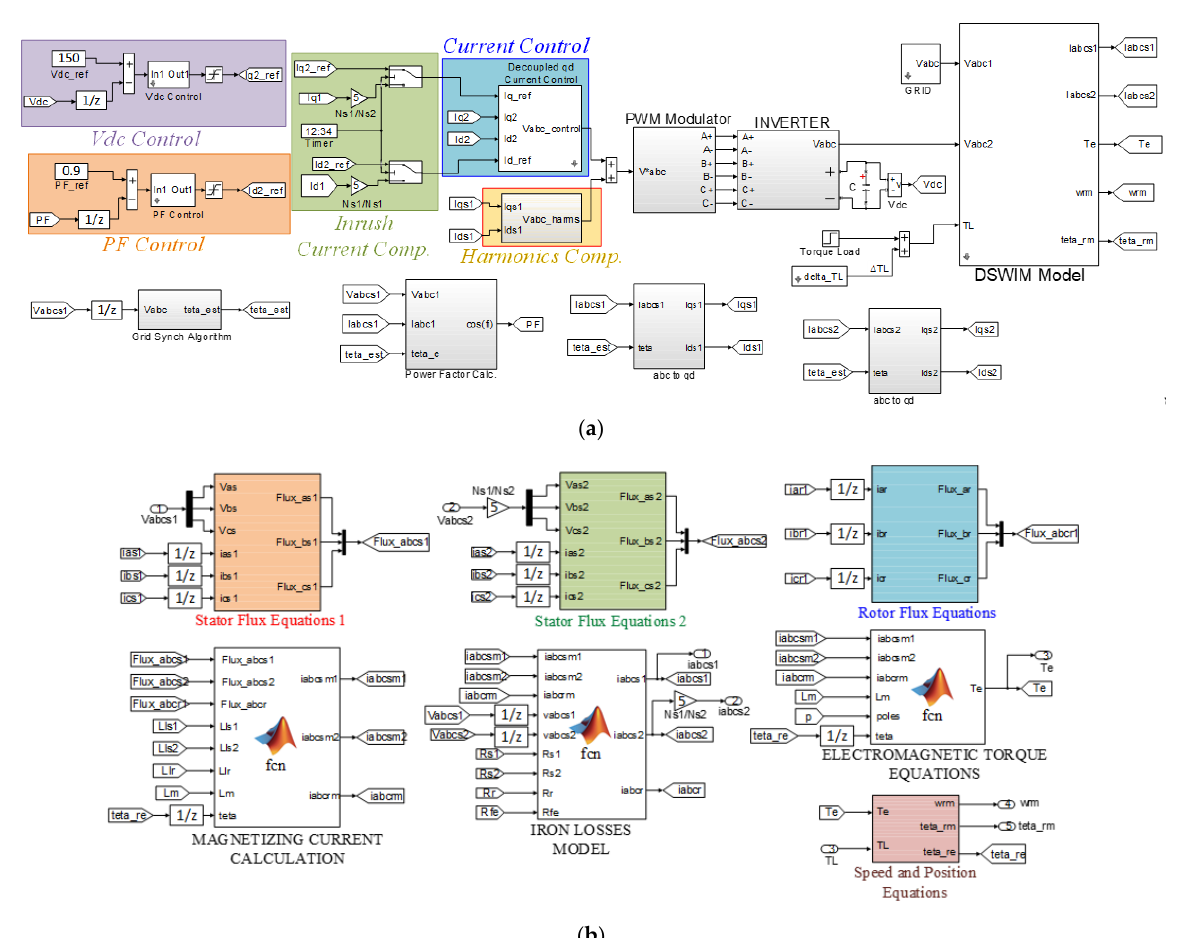
Figure 5. Simulink block diagram of the: ( a ) power conversion system and control strategies and ( b ) DOL-DWIM model.